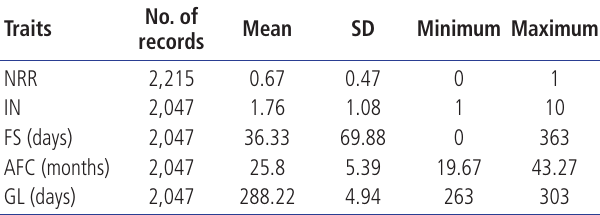
Table 1. Parameters of heifer reproductive traits Traits